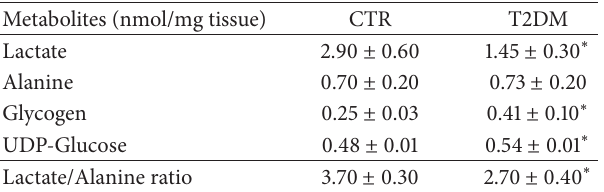
Table 3: Metabolite content of testicular tissue in animals from the control (CTR) and T2DM